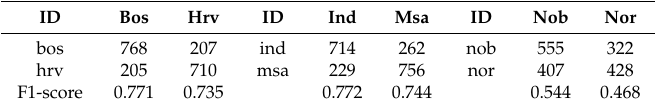
Table 12. Confusion matrix and F1-scores related to similar languages in one-stage